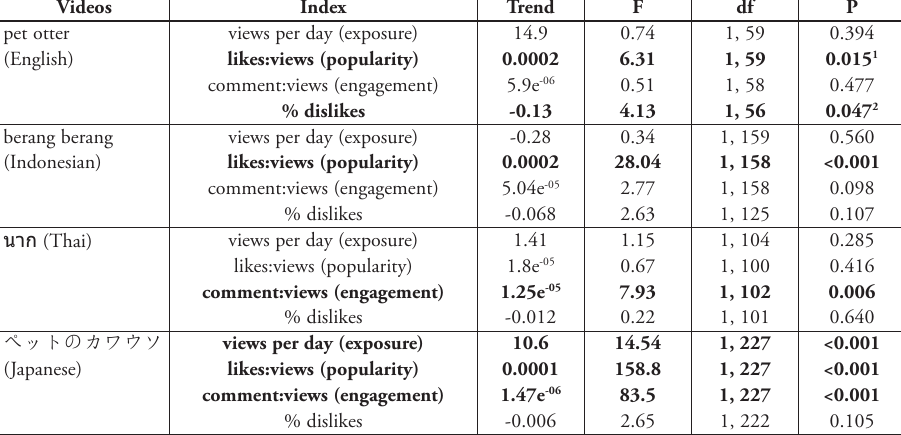
Table 1. Trend statistics for exposure, popularity and engagement indices for English-language (n=61), Indonesian (n=161), Thai (n=106) and Japanese pet otter videos (n=229), 2009–2018. In all cases, 2018 in- cludes videos posted up until the end of October (videos published in November were excluded, see Meth- ods). The trend is the average increase between successive video publications; F, df, and p values are based on ANOVA of the trend component of the time series. Statistically significant trends are shown in